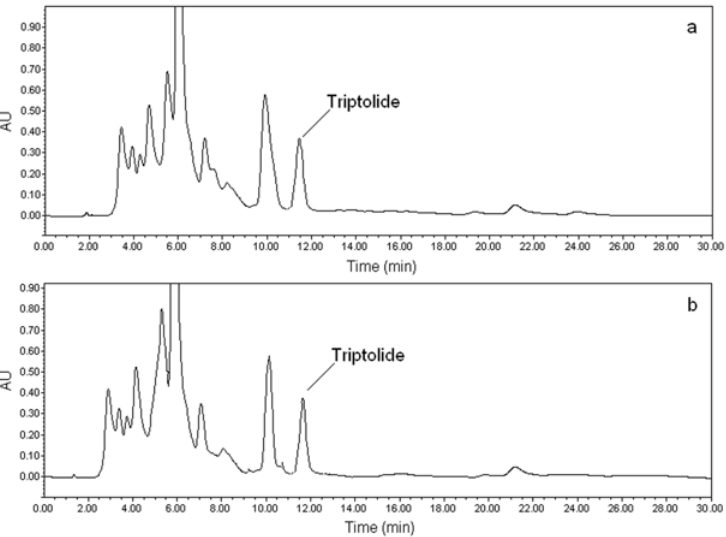
Figure 3. HPLC chromatograms of GTW. ( a ) unprocessed and ( b )